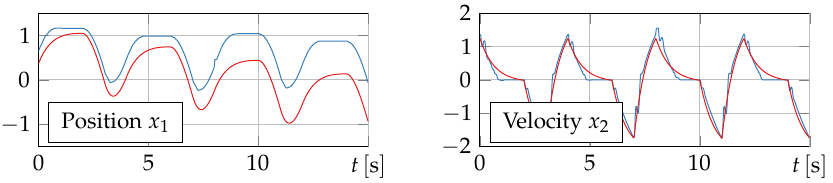
Figure 12. Comparison of the state trajectories obtained for the experimental system and the identi- fied model. Blue : results of experiment, red : results of